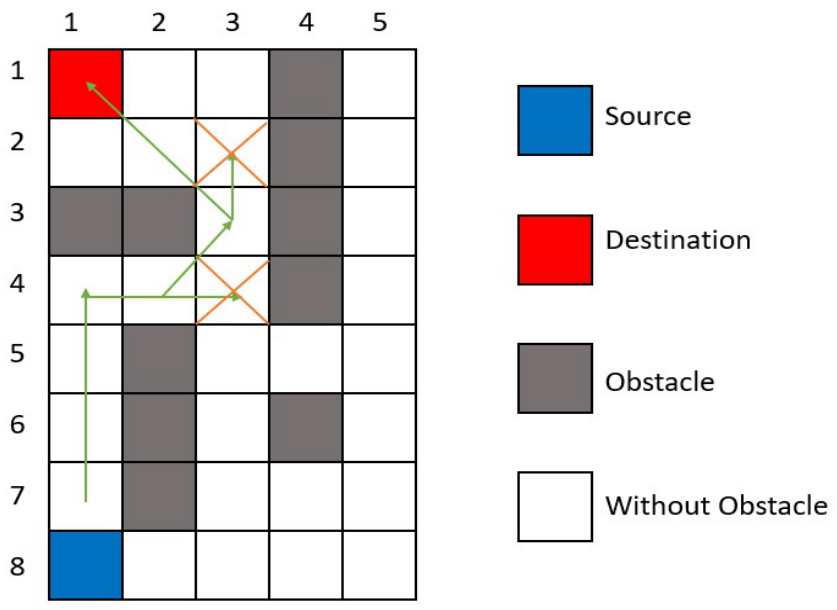
Figure 8. A* Algorithm goes from (4,2) to (3,3) and not (4,3) and similarly from (3,3) to (2,2) and not (2,3).